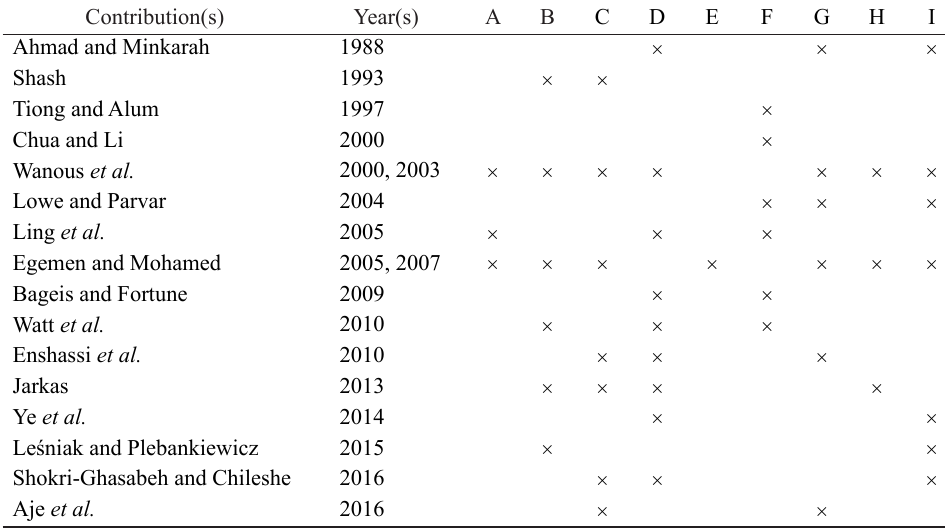
Table 2. Summary of relevant factors and their sources